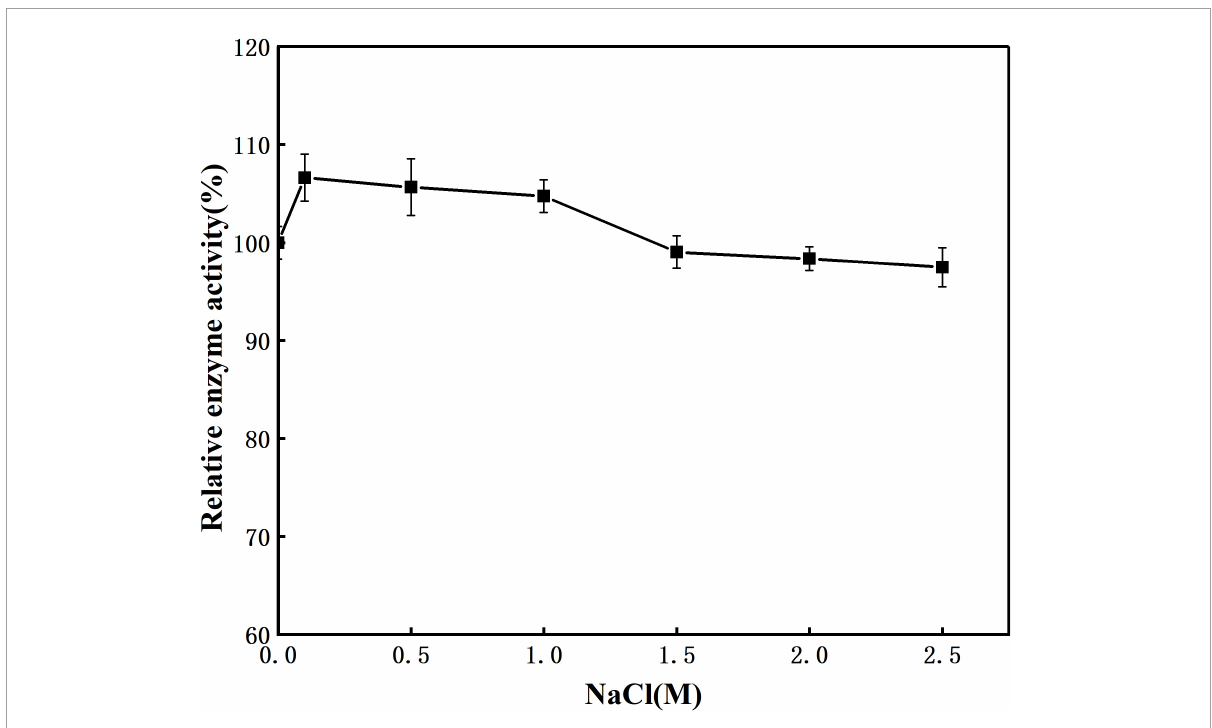
FIGURE6 Effect of salinity on the stability of the purified prot DS5.